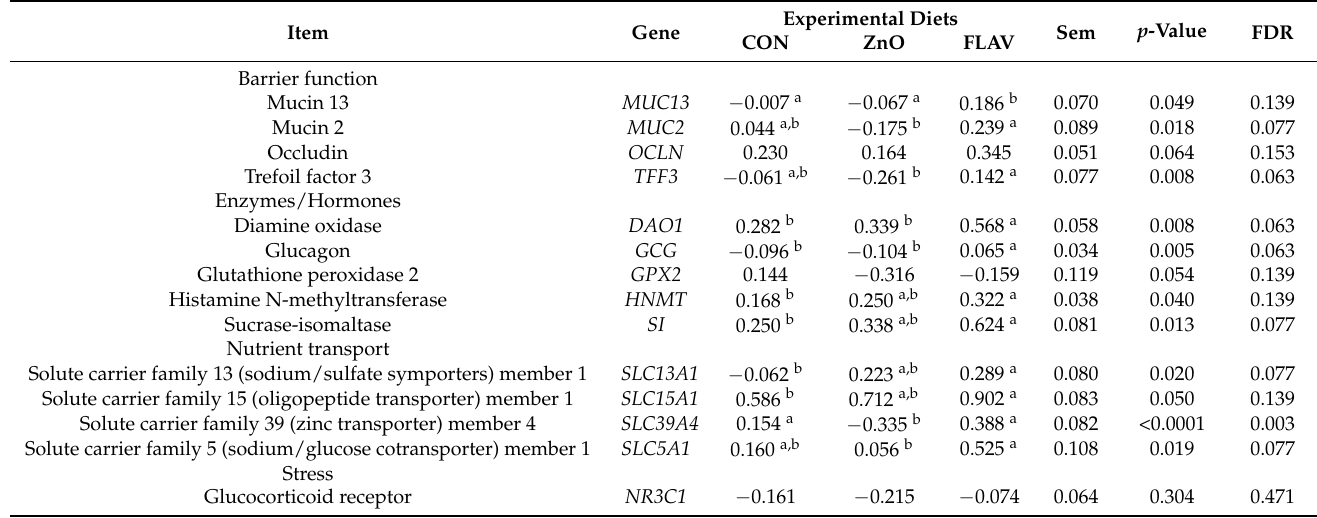
Figure 2. Heatmap and hierarchical clustering of ileum gene expression levels of pigs fed experimental diets. Significant differences are indicated using an asterisk symbol ( p < 0.10). Data are means of 6 replicate pens with 1 sampled pig per experimental diet. Table 3. Effect of experimental diets on jejunum relative gene expression of weaned pigs fed experimental diets.